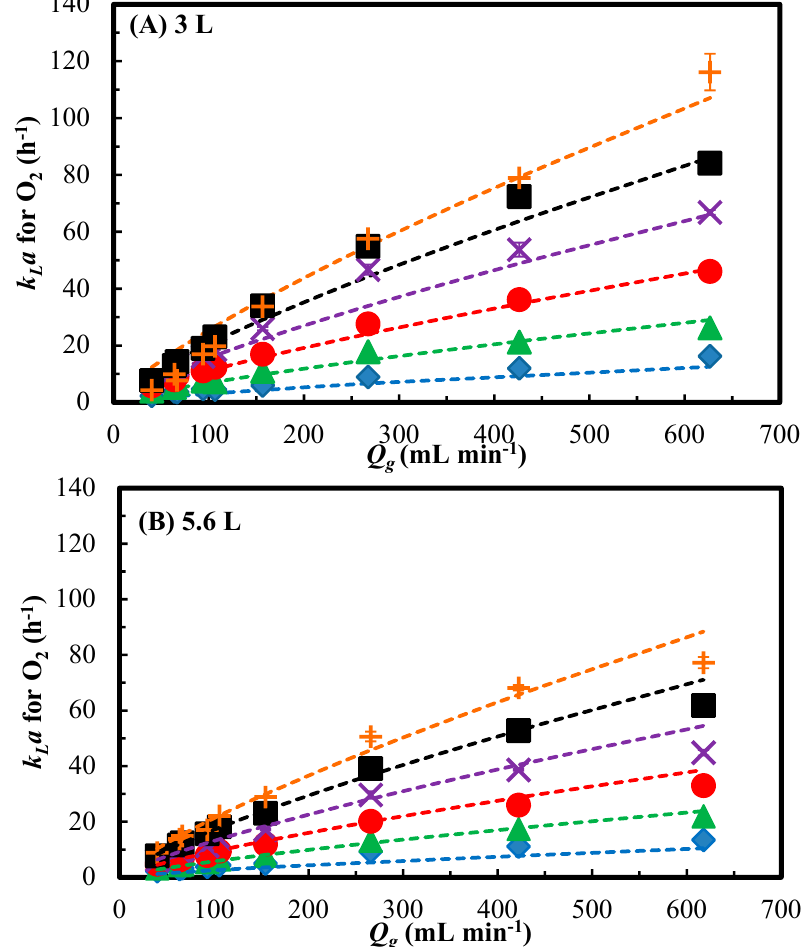
Figure 4. Experimental and predicted k L a for O 2 in (A) 3 L and (B) 5.6 L working volumes in the 7 L Bioflo 415 CSTR at volumetric flow rates between 40 mL min − 1 to 630 mL min − 1 and 37 °C and various agitation speeds: 150 rpm ( ♦ ), 300 rpm ( ▲ ), 450 rpm ( ● ), 600 rpm ( × ), 750 rpm ( ■ ) and 900 rpm ( + ); model prediction (dash lines). Error bars not visible are smaller than the symbols.